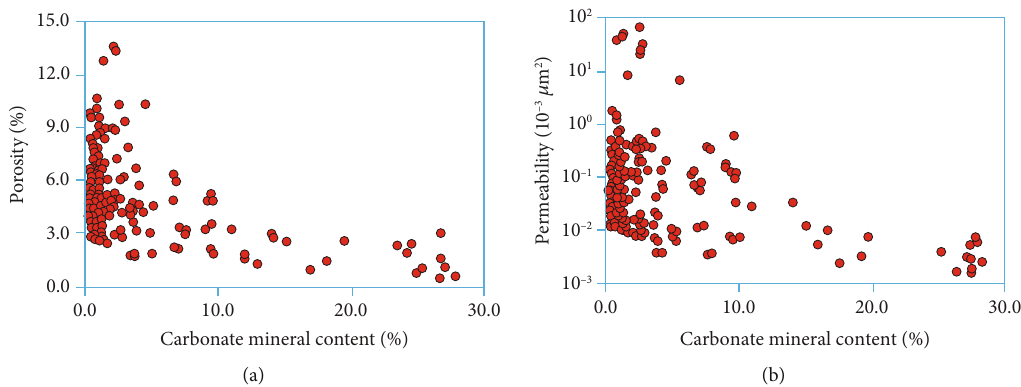
Figure 9: Relationship between content of carbonate minerals and petrophysical properties of samples in the research